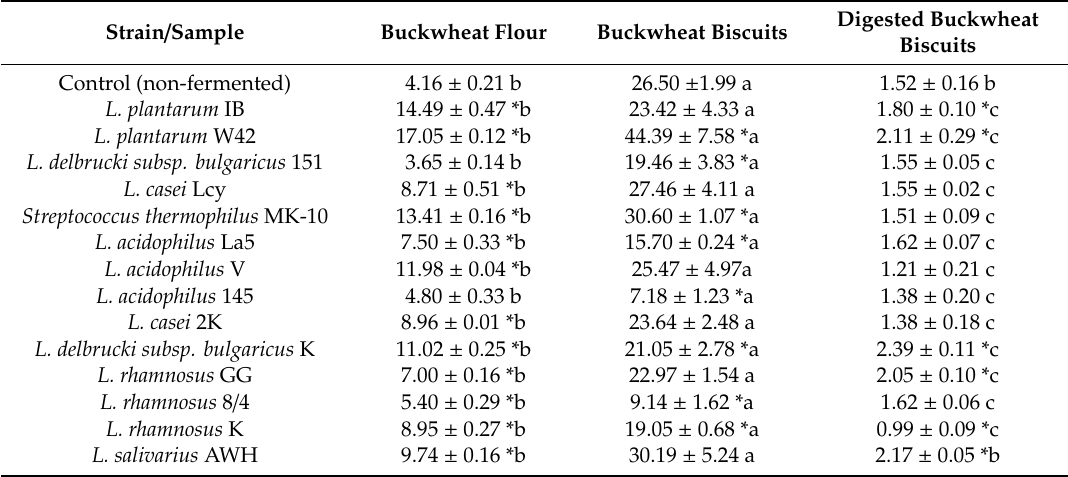
Table 1. The IC 50 of fermented buckwheat flour and water biscuits before and after in vitro digestion for angiotensin converting enzyme (ACE) inhibition (mg mL − 1